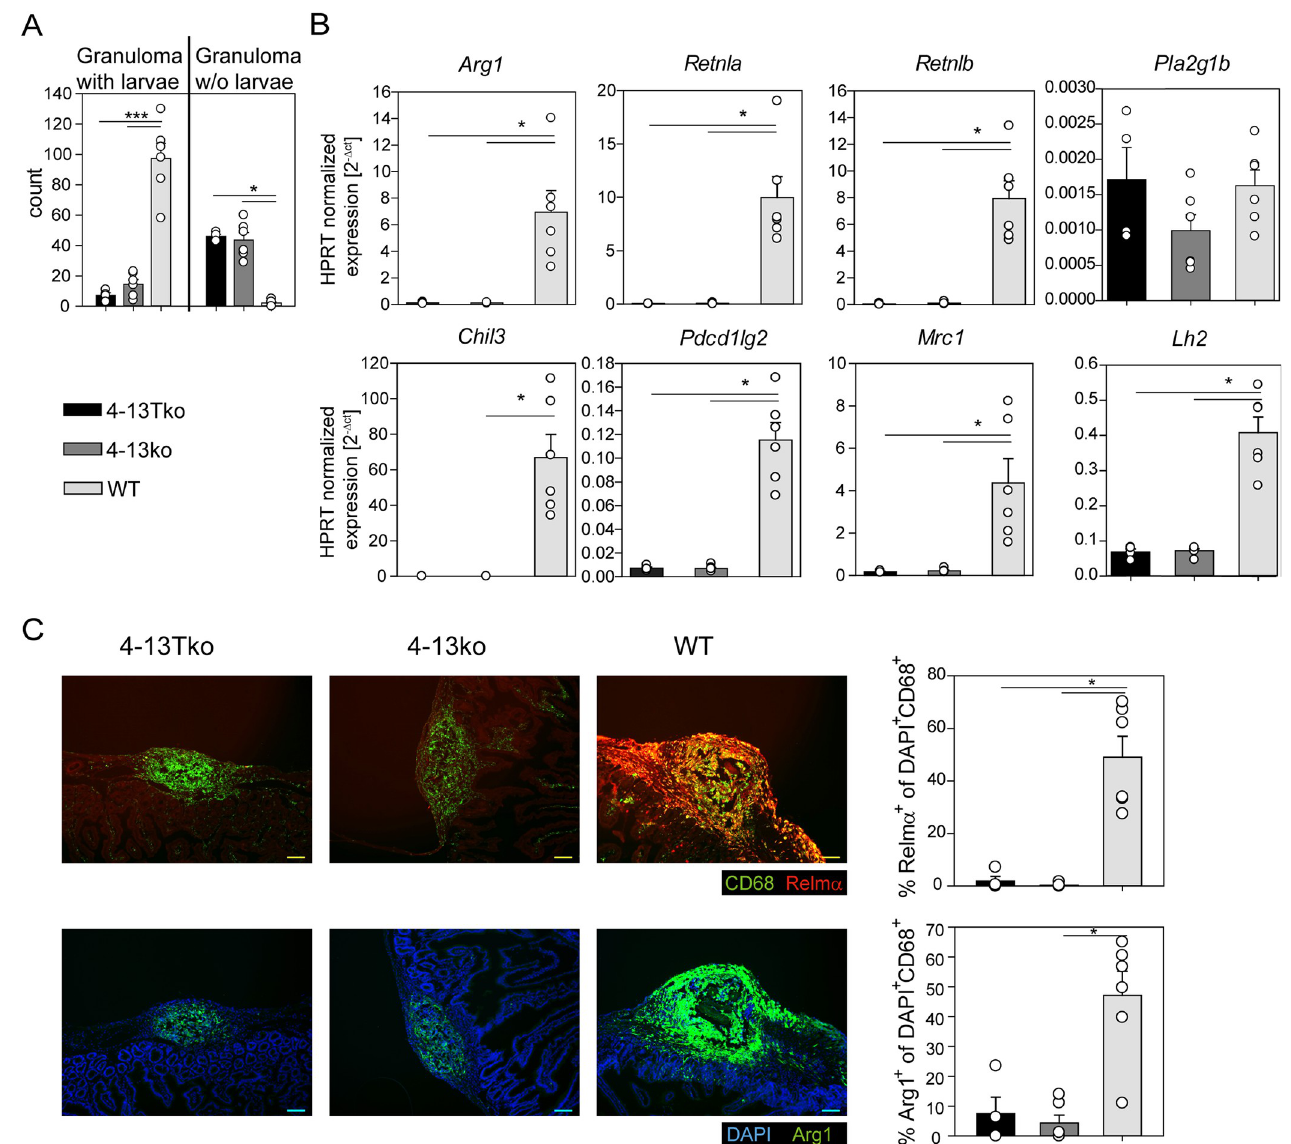
infection. A) Number of counted granuloma with or without (w/o) larvae. B) qRT-PCR data from whole small intestinal tissue for Arg1 , Retnla , Retnlb